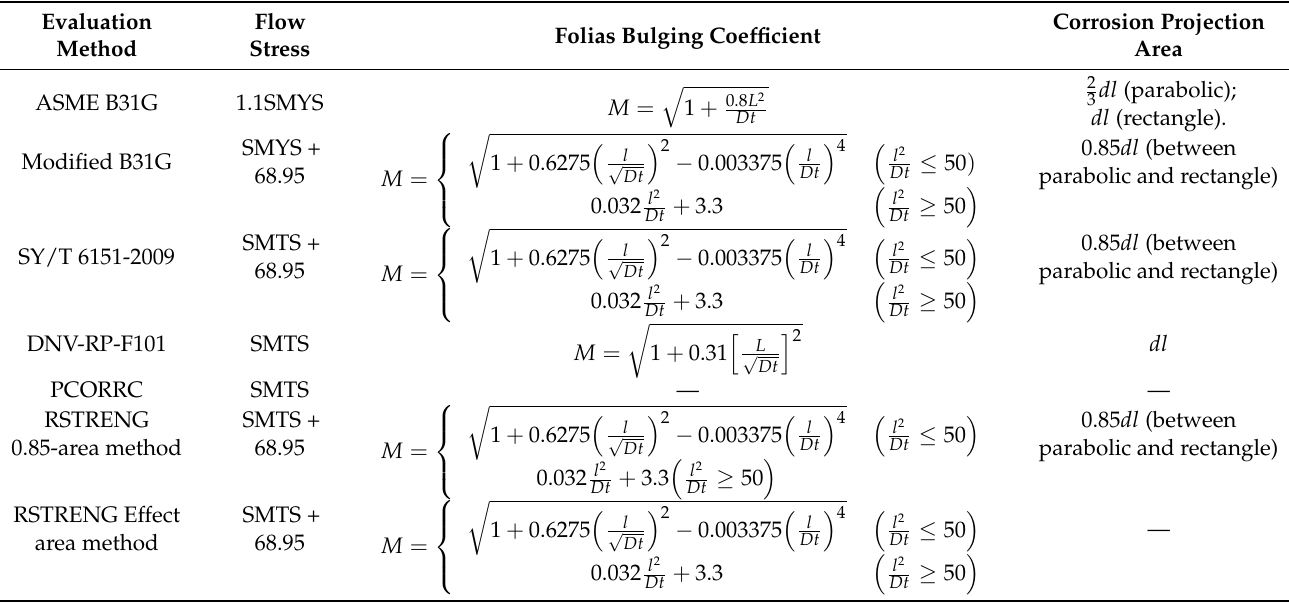
Table 1. Comparison of parameters in residual strength evaluation methods.